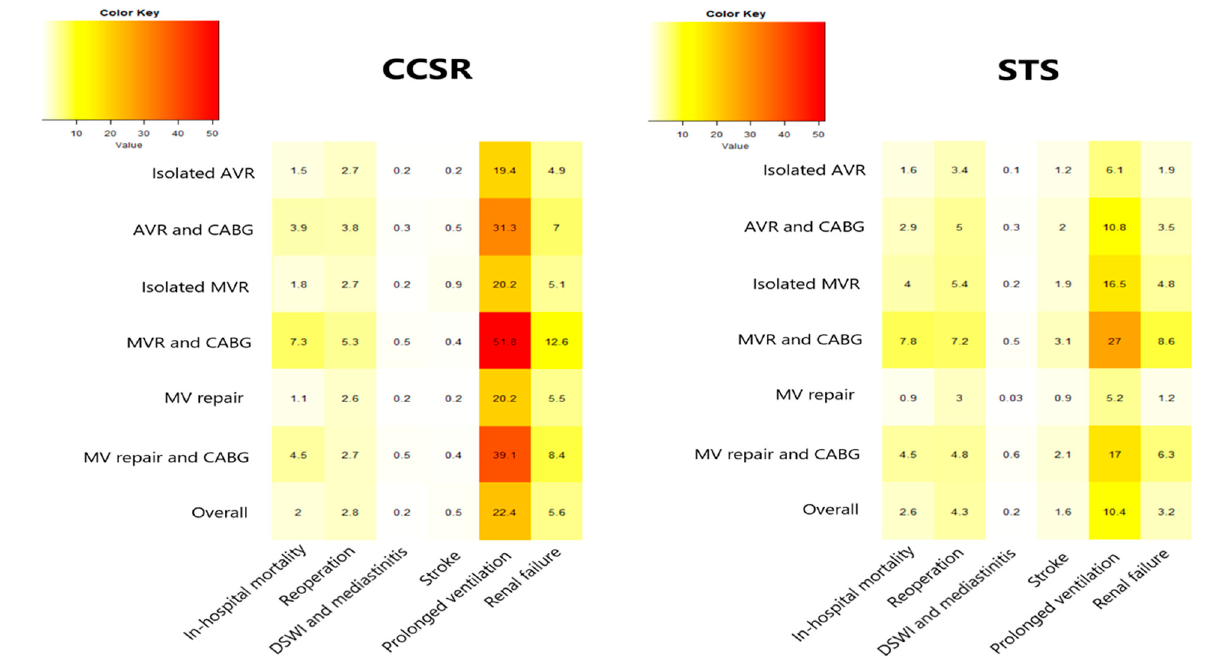
Figure 2. Distribution of in-hospital mortality and other major complication rates (%) in